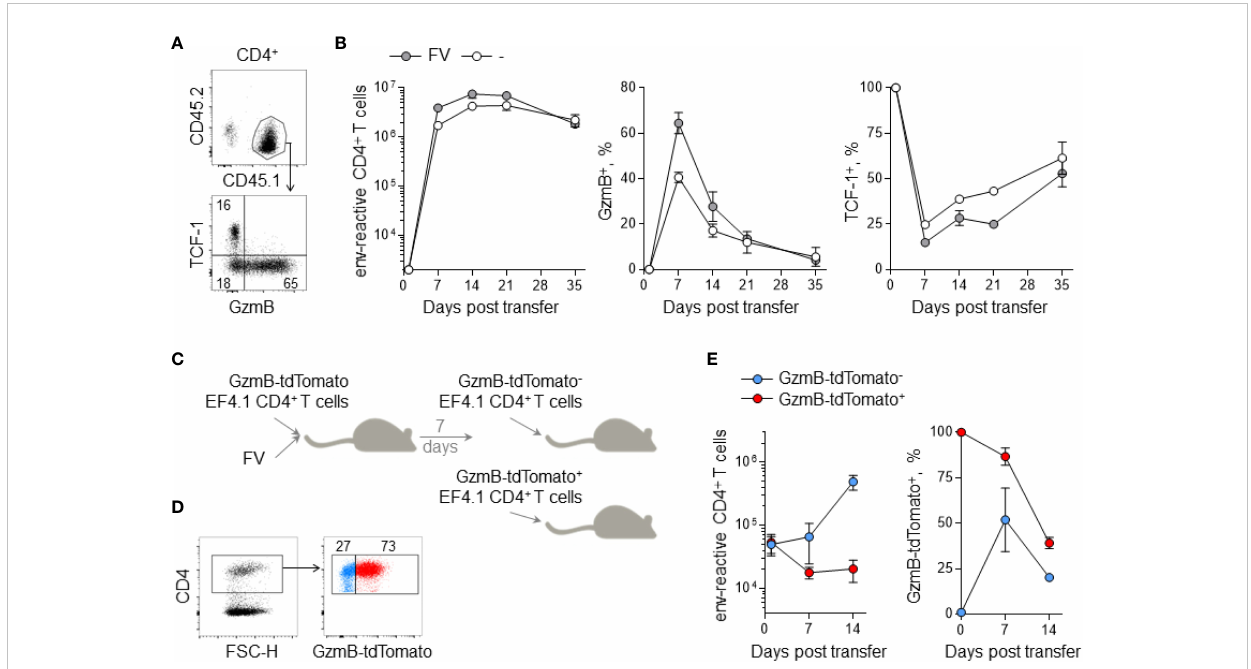
FIGURE 2 Persistence of env-reactive CD4 + CTLs in lymphocyte-de fi cient hosts. (A) Flow-cytometric detection of CD44 + env-reactive donor CD4 + T cells (top) and TCF-1 + and GzmB + CD4 + T cells (bottom) in spleens of Rag1 -/- recipient mice. (B) Absolute numbers (left), GzmB expression (middle) and TCF-1 expression (right) of env-reactive donor CD4 + T cells in the spleens of Rag1 -/- recipient mice at indicated time points after adoptive transfer with or without FV infection. (C) EF4.1 GzmB-tdTomato CD4 + T cells were adoptively transferred into FV-infected Rag1 -/- recipient mice. After 7 days, donor CD4 + T cells were sorted into either GzmB-tdTomato - or GzmB-tdTomato + fractions and injected into new Rag1 -/- recipient mice. (D) Flow-cytometric detection of GzmB-tdTomato + donor CD4 + T cells for cell sorting. (E) Absolute numbers (left) and GzmB expression (right) of env- reactive donor CD4 + T cells in the spleens of Rag1 -/- recipient mice at indicated time points after secondary adoptive